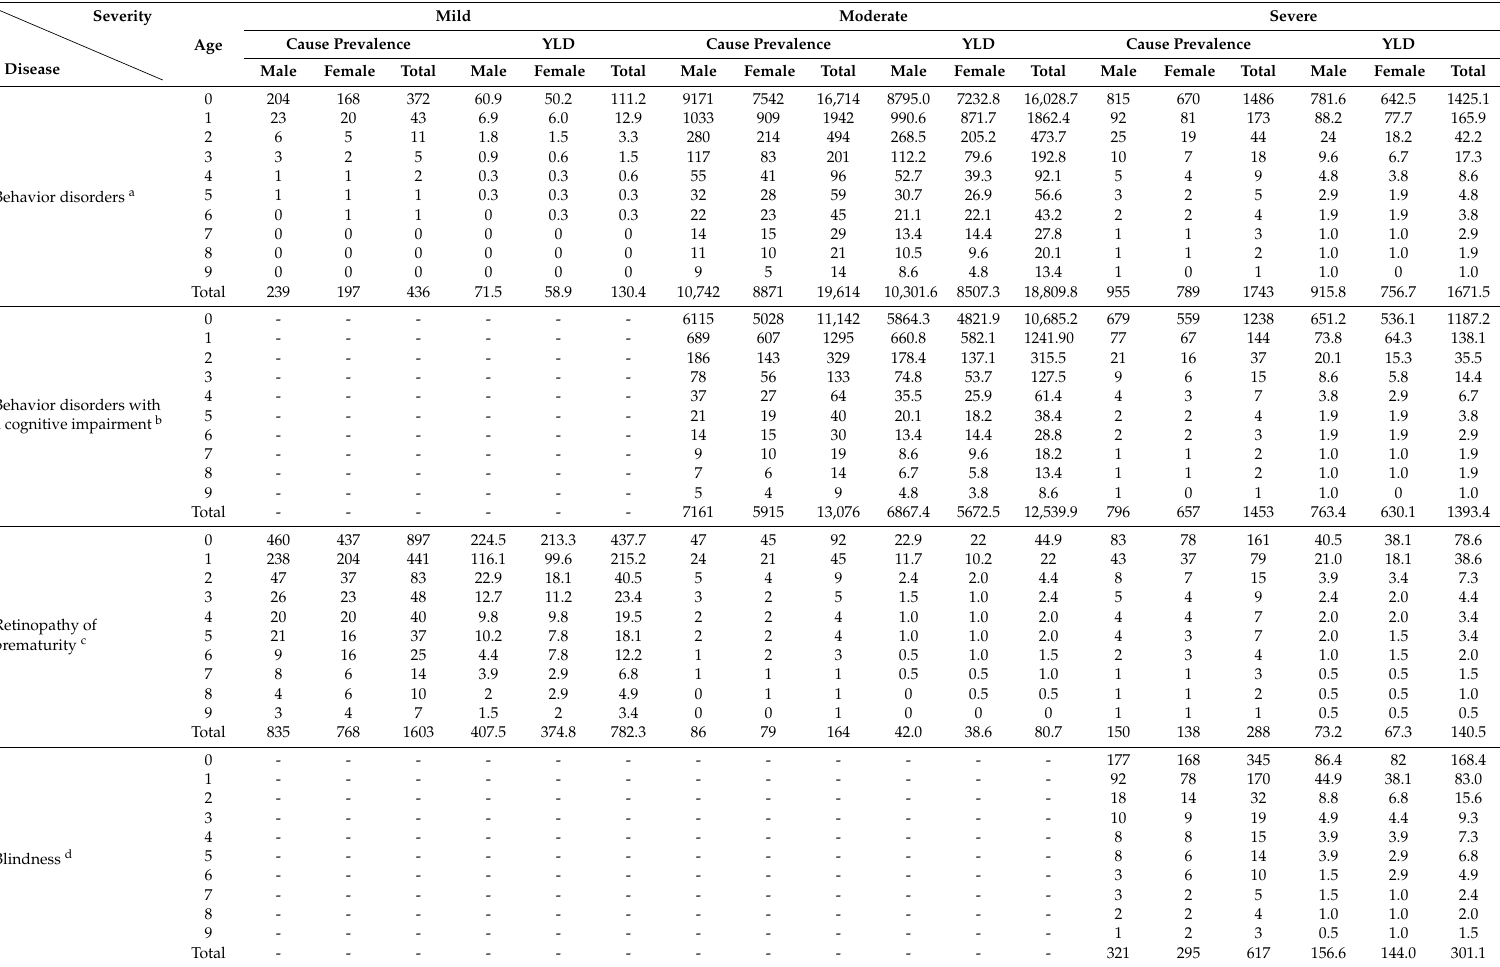
Table 3. YLD for preterm birth